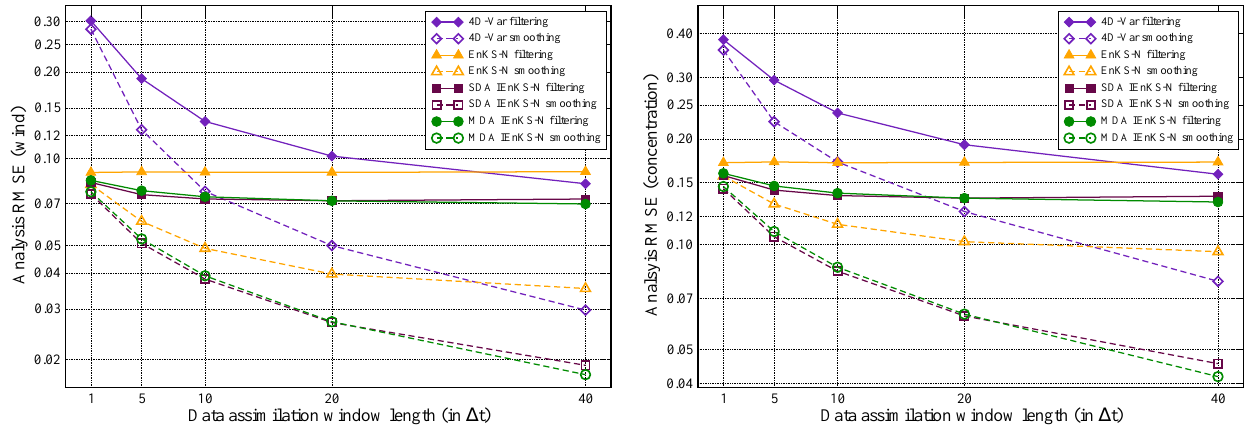
Fig. 9. Mean filtering and smoothing analysis root mean square errors of the wind variables (left) and concentration variables (right) of the online tracer model, as a function of the DAW length for the IEnKS (finite-size variant), the EnKF/EnKS, and 4D-Var (with optimal inflation of the prior).